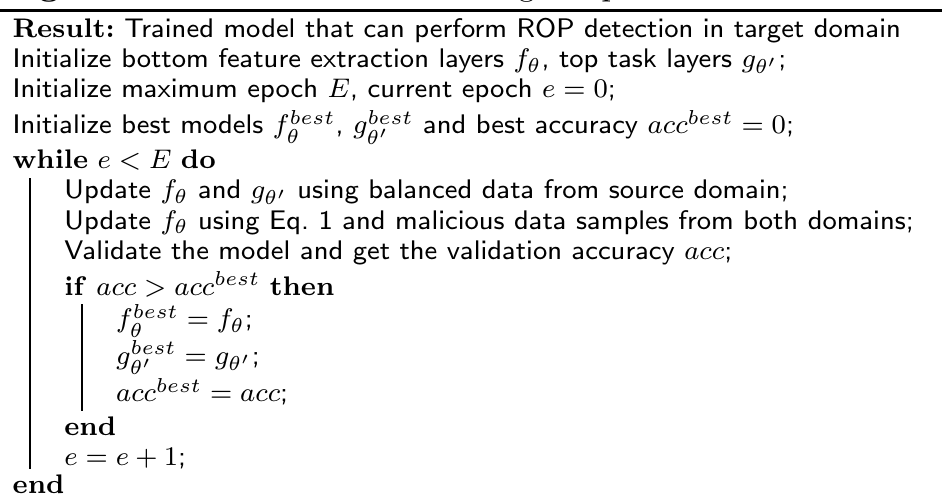
Algorithm 1: Customized Training Loop for Imbalanced Data